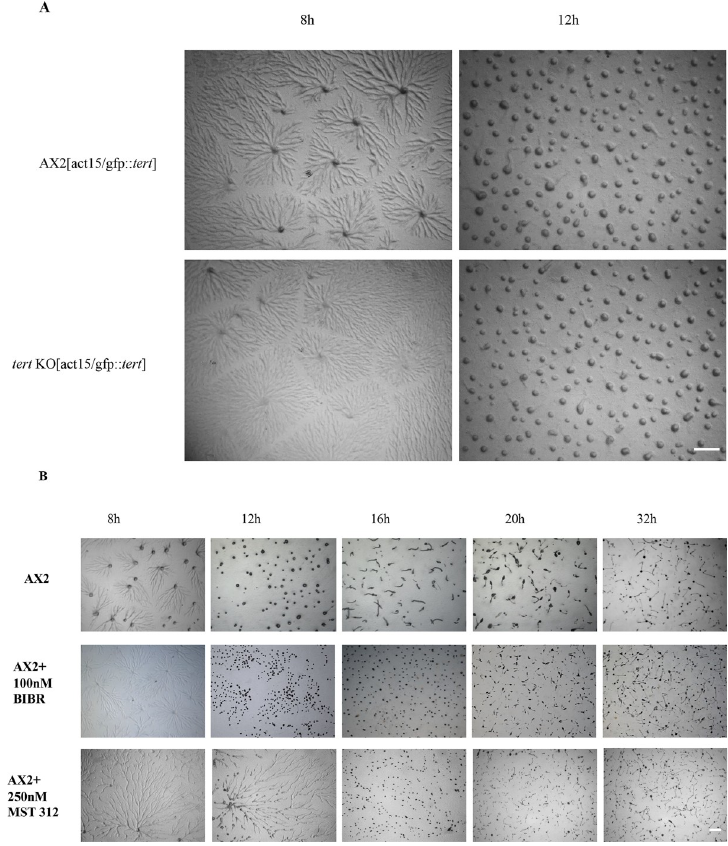
Fig 4. (A) Overexpression of TERT (act15/gfp:: tert) rescued tert KO phenotype. Scale bar: 0.5 mm; (n = 3). (B) AX2 cells treated with 100 nM BIBR 1532 or 250 nM MST 312 in KK 2 buffer and developed on KK 2 agar phenocopied the tert KO streaming phenotype. The time points in hours are shown at the top. Scale bar: 0.5 mm; (n = 3).